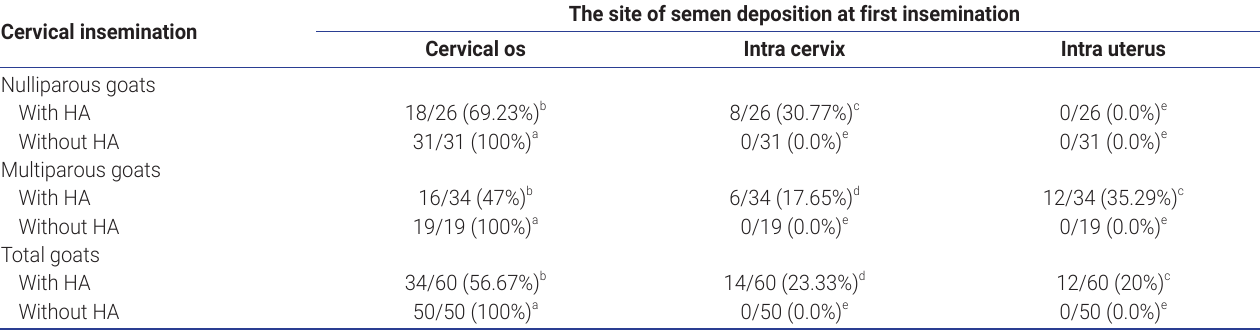
Table 2. The number and percentage of nulli- and multi-parous goats according to the site of semen deposition within the reproductive tract at the first insemination (52 h after sponge removal) 1) The site of semen deposition at first insemination Cervical insemination Cervical os